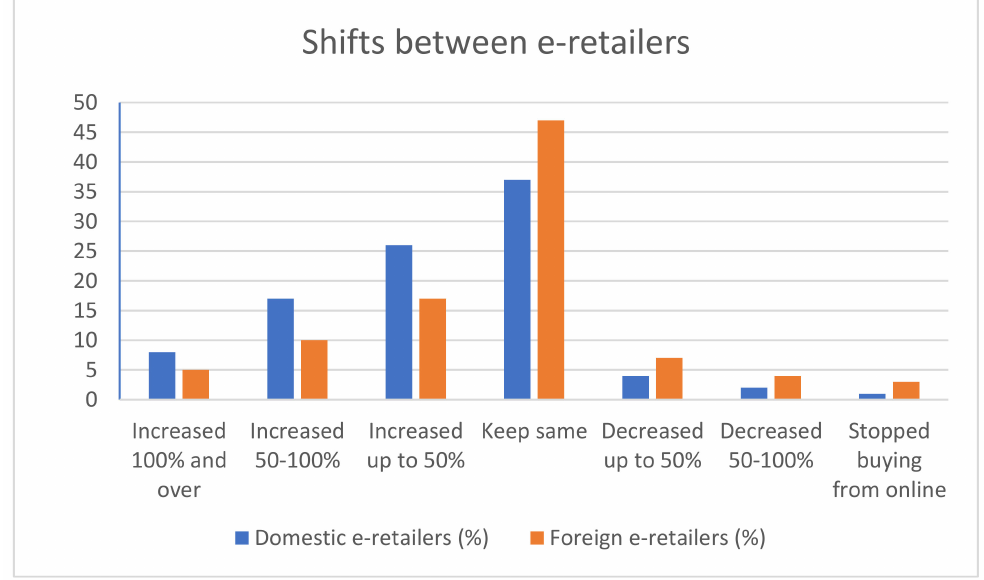
Figure 1. Domestic e-retailers vs foreign e-retailers during COVID-19.